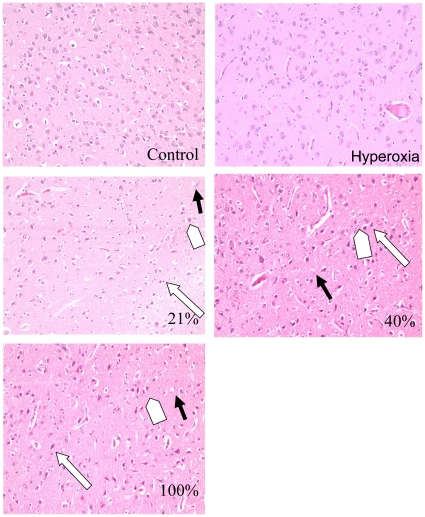
Brain histopathology.Typical morphological changes after hypoxia and reoxygenation. HE-stained sections from the corpus striatum with vacuolated neuropil (black arrow), shrunken neurons with pyknotic nuclei (white arrow), and eosinophilic neurons (arrow head) from one representative animal in each group together with HE stained sections from the control- and hyperoxia group. Obj. ×20.